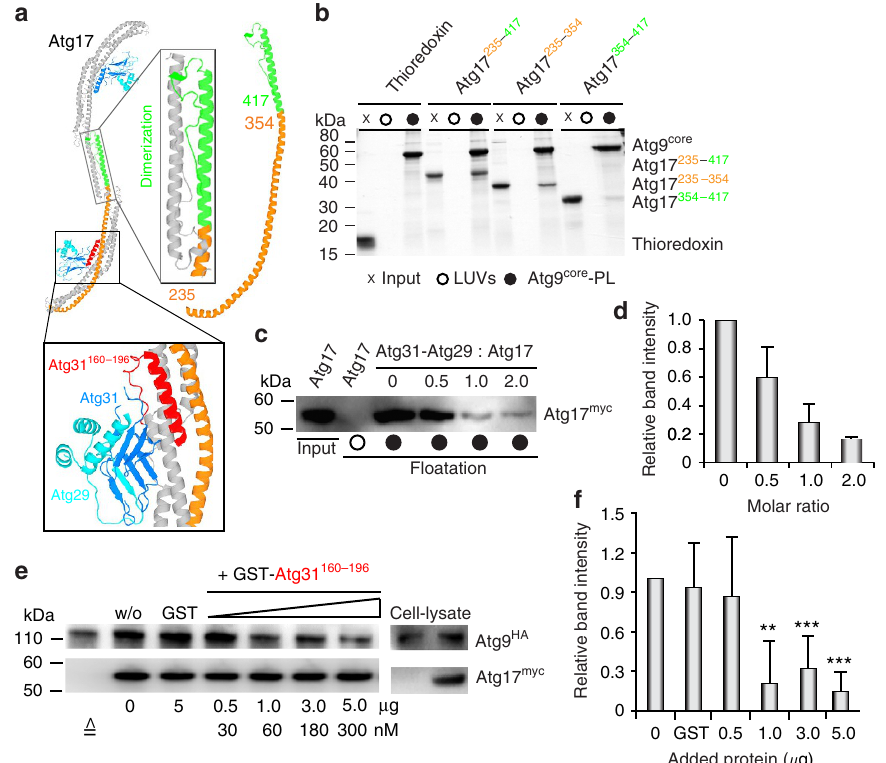
Figure 3 | Atg9 binds the central crescent of Atg17. ( a ) Cartoon representation of the crystal structure of Atg17 TC (pdb 4HPQ). Helix a 4 (orange and green) spans the entire Atg17-crescent and forms part of the dimerization domain (green). Domain borders that have been used to design Atg17-variants are indicated by numbers. The minimal Atg17-binding region of Atg31 is highlighted in red with numbers indicating corresponding domain borders. Images were prepared in PYMOL (The PyMOL Molecular Graphics System, Version 1.2r3pre, Schro¨dinger, LLC). ( b ) SDS–PAGE gel of co-floatation experiments of Atg9–PLs with recombinant thioredoxin-tagged Atg17-fragments. Thioredoxin-tag lacking Atg17 (w/o Atg17) and co-floatation with large unilamellar vesicles (LUVs) lacking Atg9 core served as controls. Input corresponds to 10% of total protein used for co-floatation. ( c ) a -myc immunoblot of co-floatation experiments of Atg17 with Atg9–PLs and increasing stoichiometric ratios of Atg31–Atg29. After incubating Atg9–PLs with Atg17, purified Atg31–Atg29 was added. Atg31–Atg29 inhibits binding of Atg17 to Atg9 in vitro . ( d ) Quantification of Atg17 retrieved from the floating fraction in co-floatation experiments with Atg9–PLs as shown in c . The intensity of the Atg17-band in the absence of Atg31–Atg29 was set to one and used for normalization. Mean values ± s.d. of N ¼ 3 independent experiments are shown. ( e ) Immunoprecipitation (IP) of Atg17 myc from cell lysates after 2h of starvation. Increasing amount of GST-Atg31 160–196 as indicated or 5 m g GSTwere added to cell lysates prior IP. Atg17 and co-immunoprecipitated Atg9 were detected by a -myc and a -HA immunoblots. ( f ) Quantification of Atg9 HA as shown in e . The intensity of the Atg9 HA -band (w/o GST-Atg31 160–196 ) was set to one and used for normalization. Mean values ± s.d. of N ¼ 3 independent experiments are shown. P values were calculated using two-tailed Student’s T -test (* P o 0.05; ** P o 0.01; *** P o